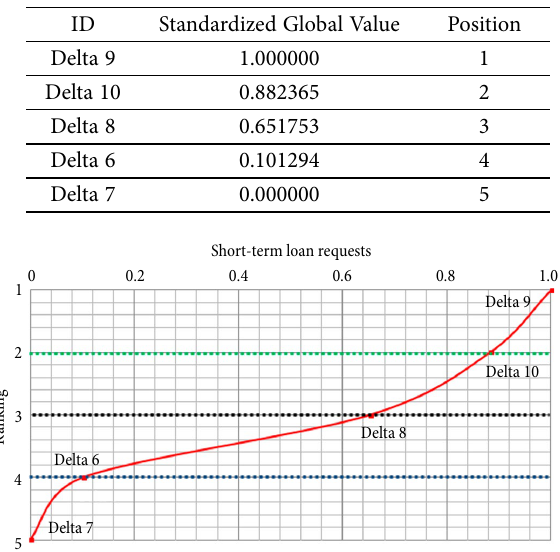
Fig. 5. Standardized global value and respective position